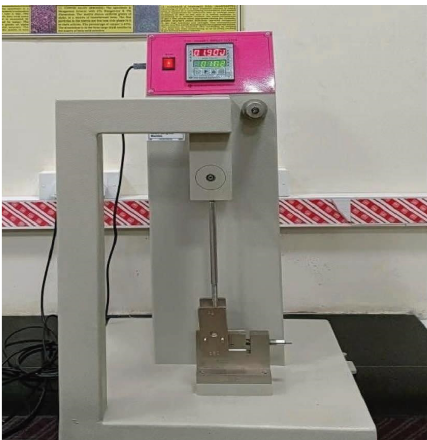
Figure 4: Impact testing